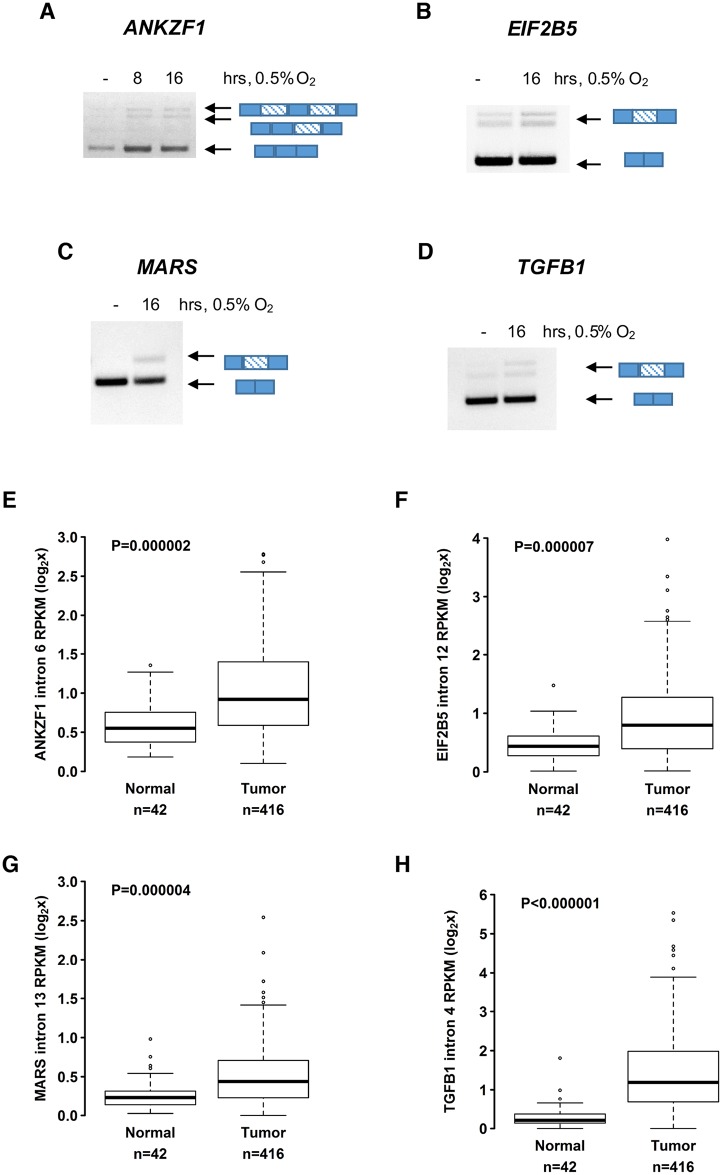
Hypoxia-induced retained introns (RIs) for several genes are confirmed by PCR and expression analysis of head and neck tumors.For each panel, PCR validation of intron retention events using cDNA prepared from oligo-dT–selected mRNA treated with DNAse enzymes is shown. Genes include (A) ANKZF1, (B) EIF2B5, (C) MARS, and (D) TGFB1. Diagrams beside gel images of PCR products depict gene locus models with exons as solid blue and introns as striped rectangles. For each gene, expression analysis for HNSC tumor and matched normal tissue data is shown below—(E) ANKZF1, (F) EIF2B5, (G) MARS, and (H) TGFB1. Data used in the generation of this figure are included in S1 Data.